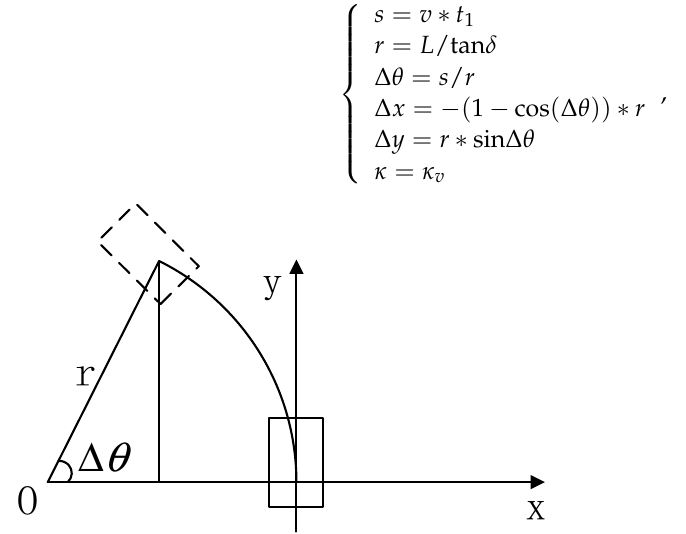
Figure 3. Schematic diagram of vehicle position prediction.